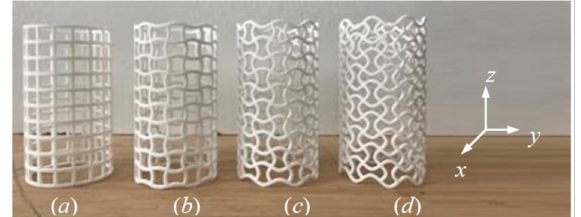
Figure 2. The 3D-printed experimental samples using the nylon materials: ( a ) CSHT0, ( b ) CCHT1, ( c ) CCHT2, and ( d ) CCHT3.